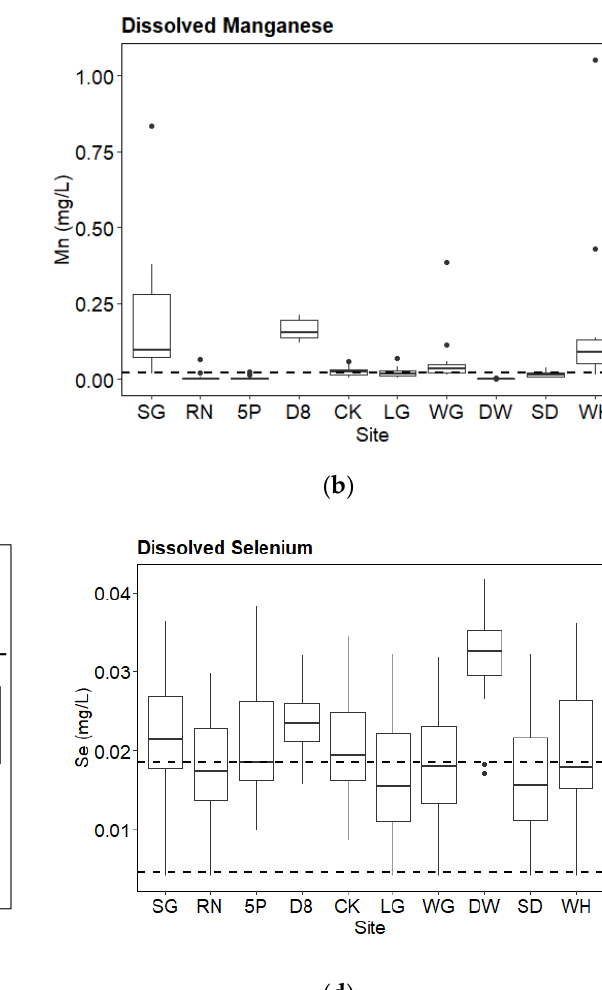
Figure 3. Boxplot results with the CDPHE standard for E. coli .